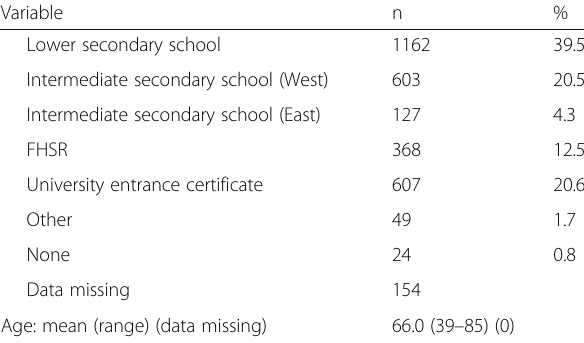
Table 1 Characteristics of the patients included in the study